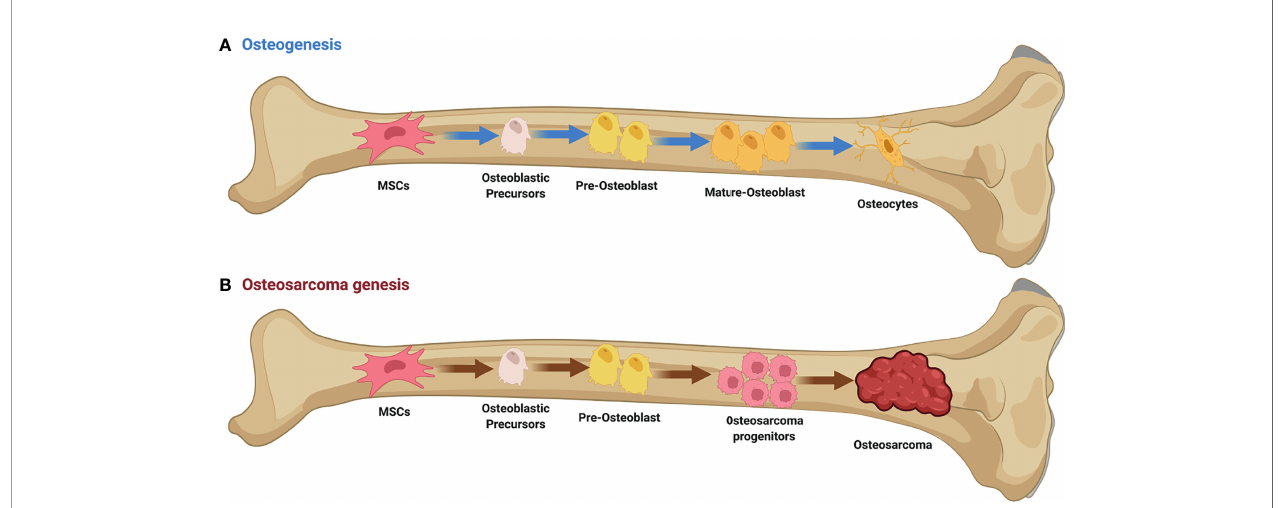
FIGURE 1 | Osteogenesis and Osteosarcoma genesis. (A) Initiation of osteogenic differentiation from mesenchymal stem cells (MSCs). MSCs are multipotent bone marrow cells that are capable of differentiating to bone (osteoblast/osteocyte), fat (adipocyte), and cartilage (chondrocyte) tissues. (B) Defects in osteogenesis lead to osteosarcoma genesis. Genetic alterations probably interfere with the normal osteogenic process, resulting in incompletely differentiated osteoblasts or osteocytes in bone. These defects disrupt the balance between proliferation and differentiation, and may cause a group of cells to display uncontrolled cell proliferation. Osteosarcoma progenitors may arise from these cells and expand to form osteosarcoma. This fi gure was created with